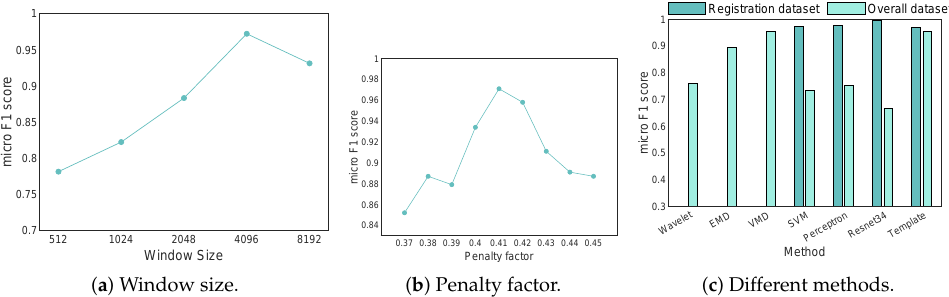
Figure 13. Performance of SingMonitor with different